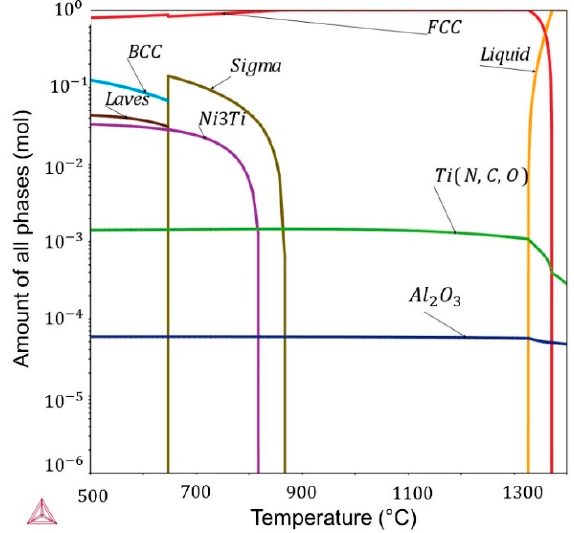
Figure 2. Temperature dependence of equilibrium amount of all phases in one mole of Alloy 825. “FCC” is a nickel-rich face-centered cubic phase, “BCC” is a body-centered cubic phase with the approximate composition M(C,N) 3 , “sigma” and “laves” are intermetallic phases, other phases have the approximate chemistries specified in the corresponding labels.